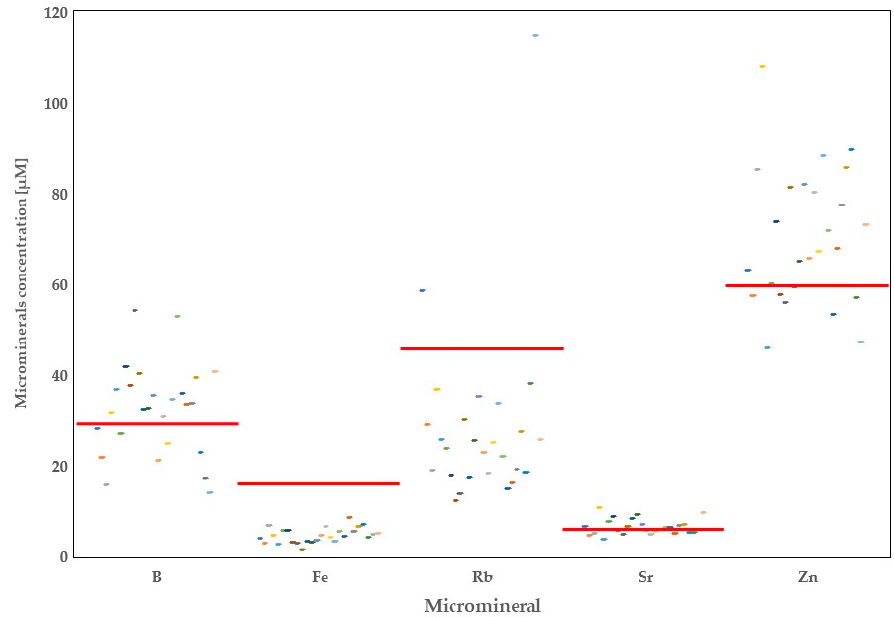
Figure 2. Distribution of microminerals (boron, iron, rubidium, strontium, and zinc) in Alberta milk samples with regards to world averages (red line).